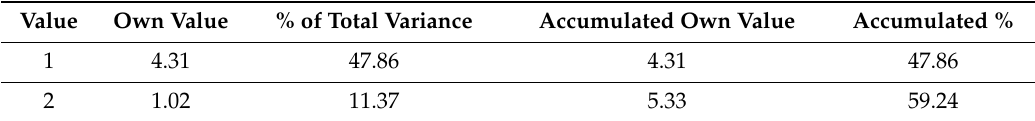
Table 5. Total complete variance within the model.